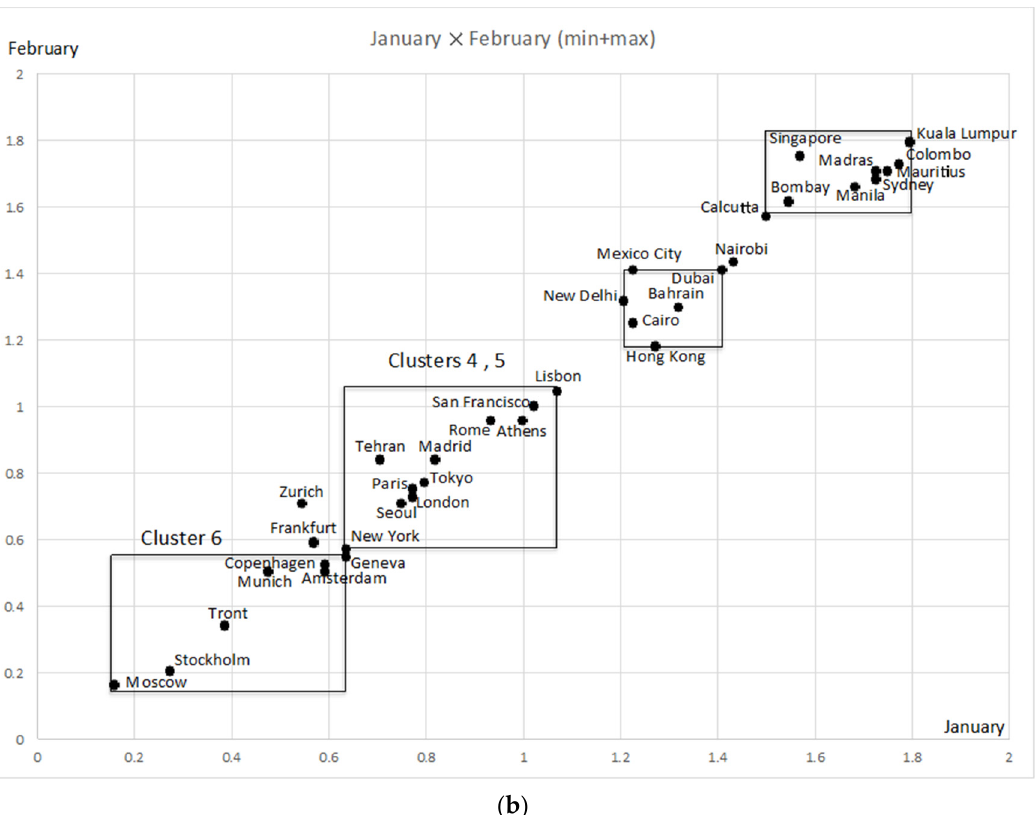
Figure 15. ( a ) Cluster descriptions for February and May. ( b ) Cluster descriptions for January and February.